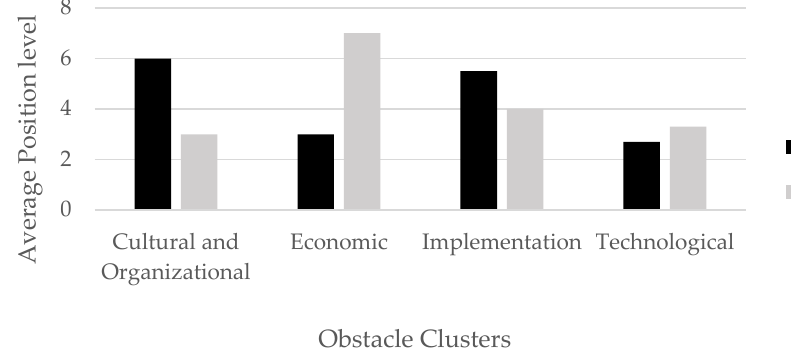
Figure 15. Aggregate positioning of obstacles.